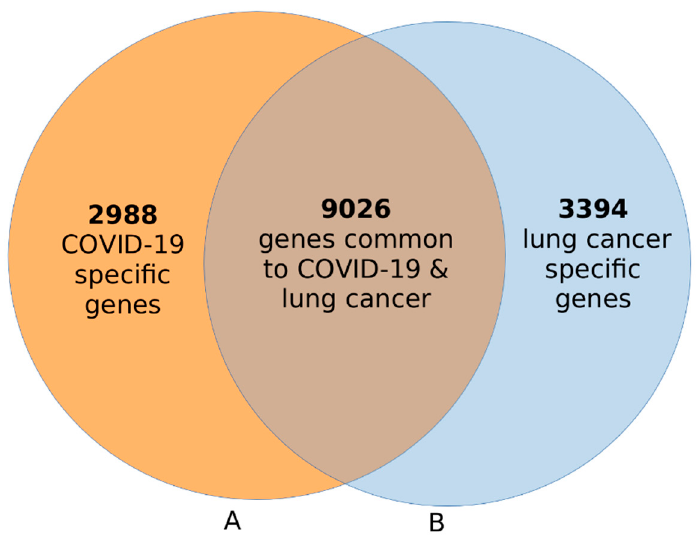
Figure 2. Venn diagram showing signatures of genes uniquely associated with COVID-19 (( A ), orange) and a signature of genes associated with lung cancer (( B ), blue). A signature of 9026 genes associated with both diseases is shown in the intersection.